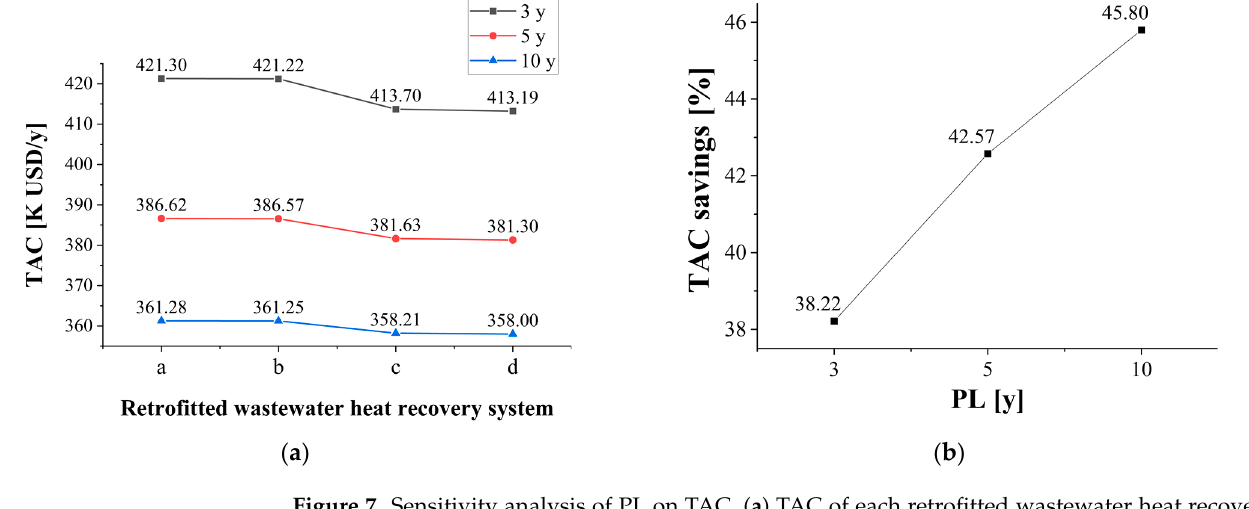
Figure 7. Sensitivity analysis of PL on TAC. ( a ) TAC of each retrofitted wastewater heat recovery system as 𝑃𝐿 changes, ( b ) Maximum TAC savings as 𝑃𝐿 changes.